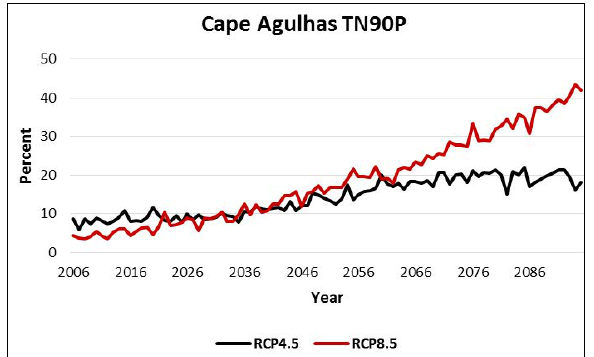
Figure 10: Ensemble mean simulation of TN90P (in % with basis period 2006–2035), under the RCP4.5 and RCP8.5 emission scenarios, as indicated.